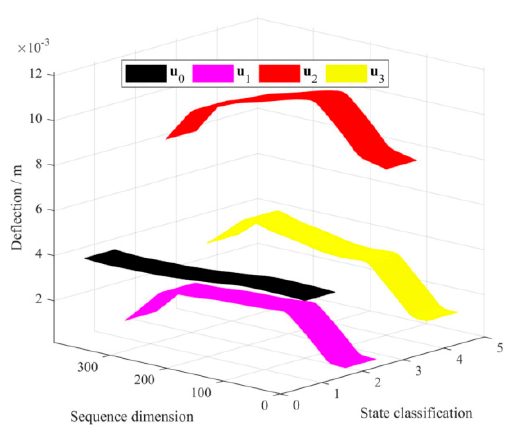
Figure 5. Truncated deformations depicted by continuous deflections.